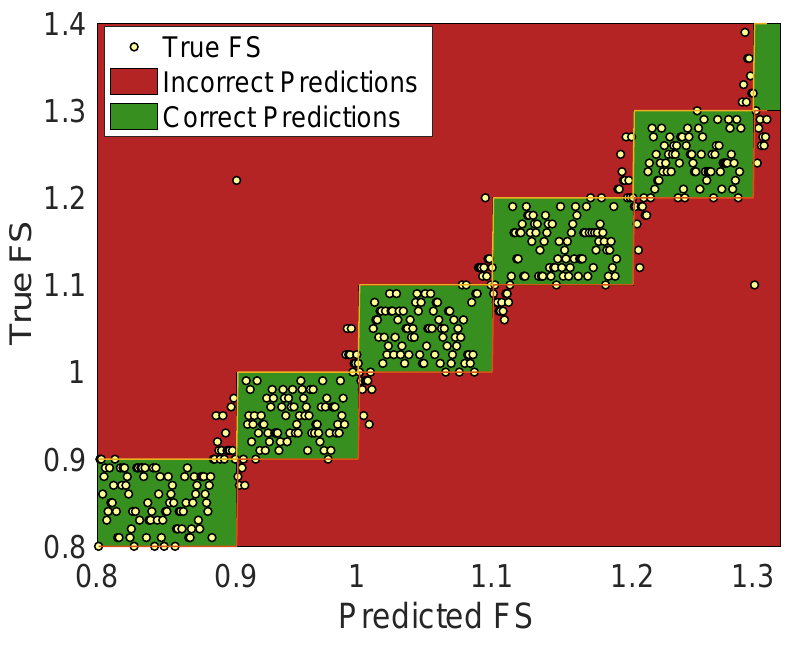
Figure 9. The comparison between the LEM and the classification model. Figure 10 plots the FS values obtained by different analysis methods for a subset of the testing data. This figure contains 226 randomly selected slope images. The slopes were sorted based on their true FS s. A solid line was then used to represent the true FS values of the slopes. There are five types of markers in this figure: four of them belong to the four LEMs implemented in this study, and one is for the predictions of the regression model. The results are demonstrated in two sections for plotting purposes. The main plot shows 200 images for FS values up to 1.8, and the subplot at the upper left corner shows 26 slopes with higher FS s. The comparison indicates that all of the predicted FS s were quite close to the true FS s calculated as the average FS of the four LEMs. Further analysis of this plot shows that the BSM underestimated the FS s for most slopes, while JCM and JSM tended to overestimate them. Despite this difference, the predictions of the regression model, true FS s, and the OMS results were similar to one another. This plot also shows that, for the majority of the slopes, the predictions of the deep learning models were within the highest and lowest FS s obtained with the four LEMs and were more accurate than all of them. Another important observation from this figure is the ability of the regression model to distinguish between images within the first and ninth categories. While there was only one class for each of these wide ranges in the classification model, the regression model could estimate the FS values of these images instead of categorizing them as “lower than 0.8” (first category) or “higher than 1.5” (ninth